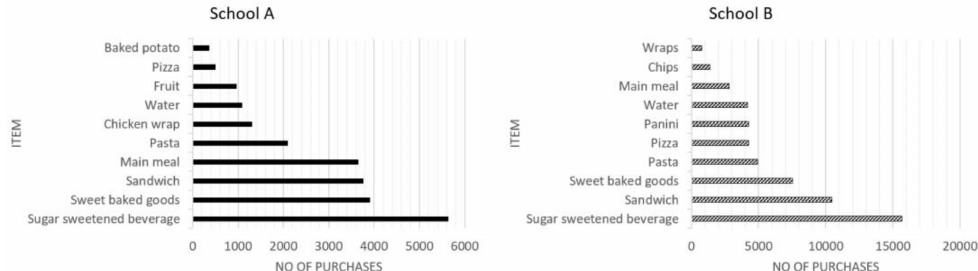
Figure 3. Top ten food and drink purchases at lunchtime by school (total sales data).